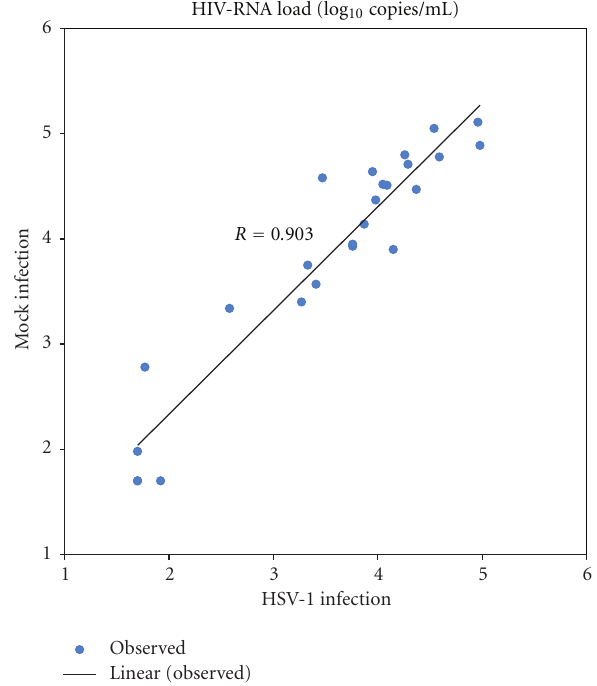
Figure 2: Correlation of HIV-RNA load between mock and HSV-1 infected PBMCs of 25 HIV-infected